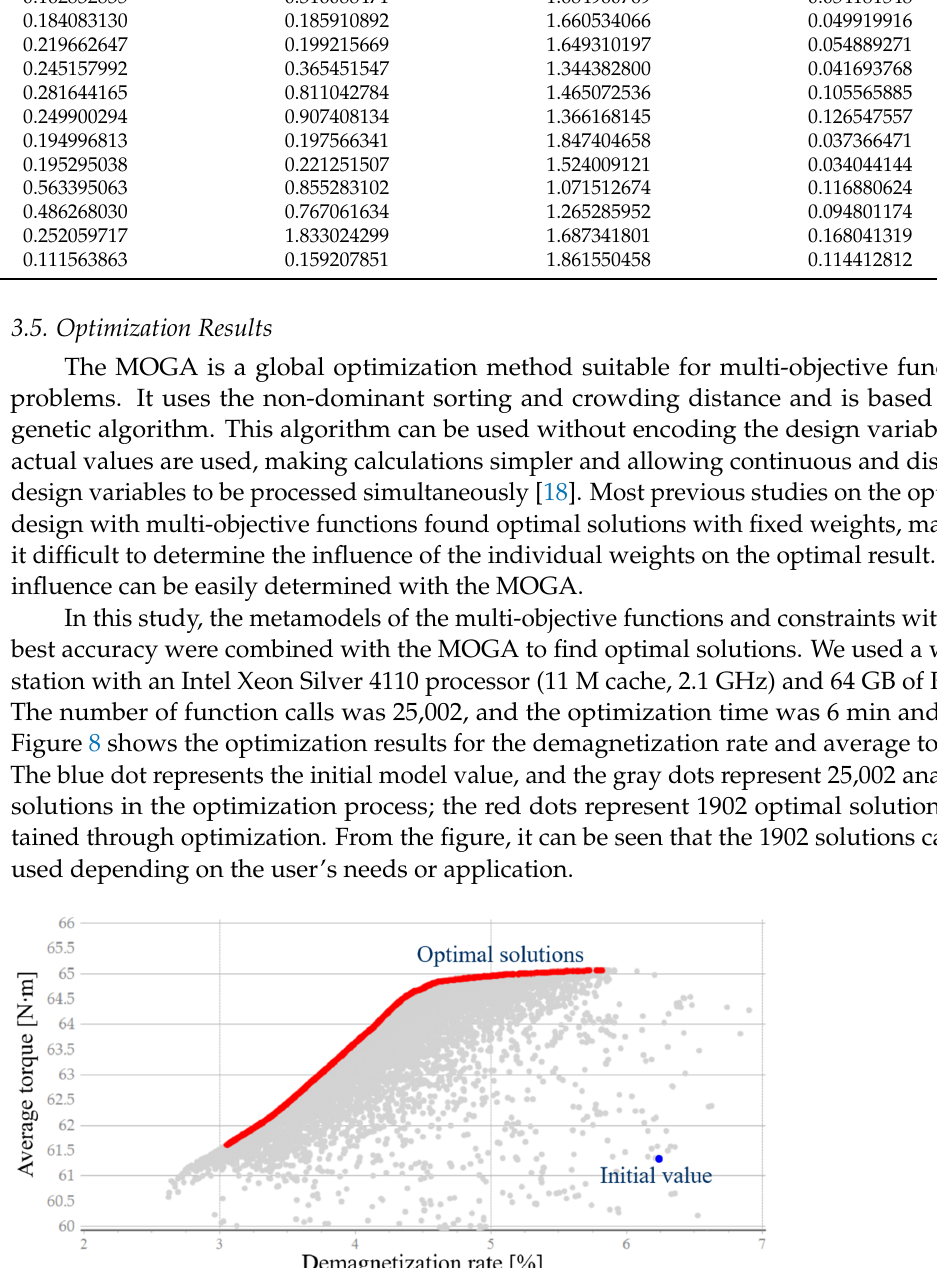
Figure 9. Change of multi-objective function according to weight change.